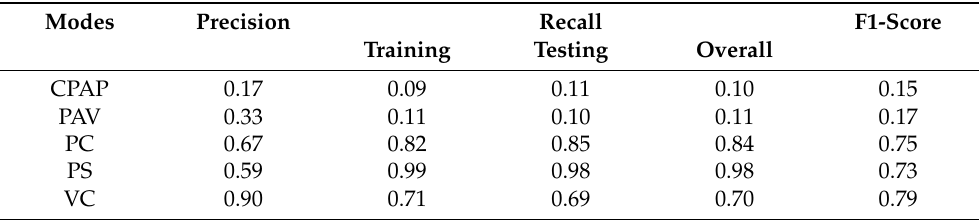
Table 8. Model evaluation report for Logistic-Regression